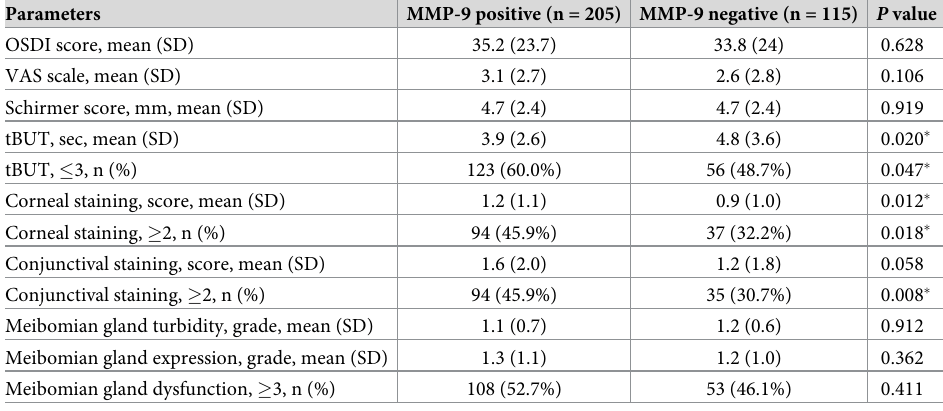
break-up time. � Statistically significant by independent two-sample t-test or Pearson’s chi-square